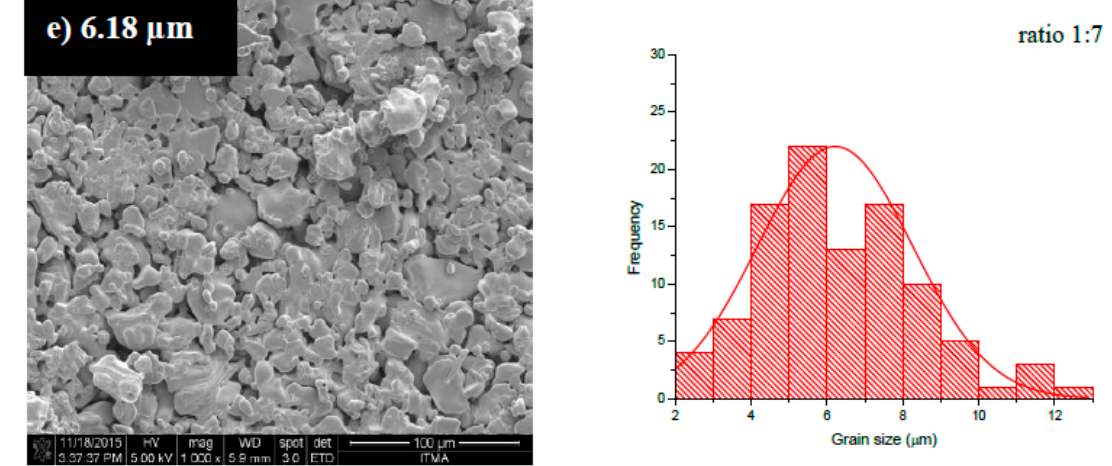
Figure 4. FESEM images of BaFe 12 O 19 sintered at 1300 °C with ratios of ( a ) 1:3, ( b ) 1:4, ( c ) 1:5, ( d ) 1:6, and ( e ) 1:7.